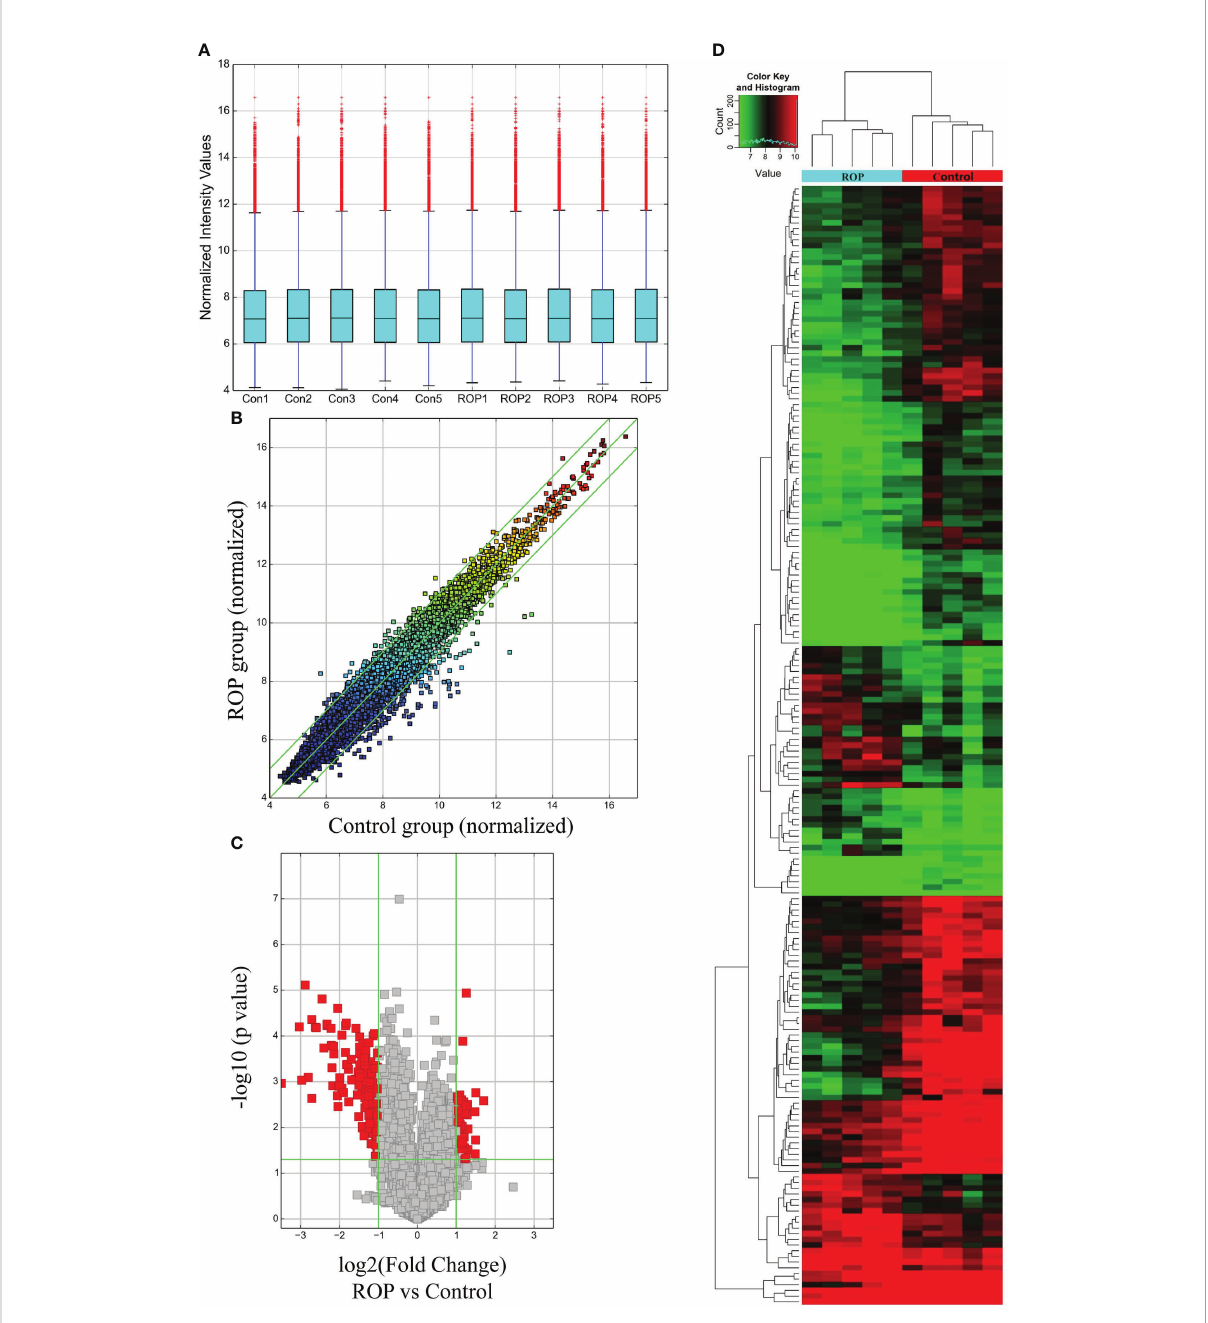
FIGURE 1 Expression pro fi le of circRNAs in retinopathy of prematurity (ROP) patients and controls. (A) A box plot shows the expression pro fi le of circRNAs in each blood sample after normalization. (B) Raw variations of the circRNA expression pro fi le are displayed on a scatter plot. (C) A volcano plot shows signi fi cantly altered circRNAs using a threshold of ≥ 2-fold change and P<0.05. (D) Heatmap derived from hierarchical cluster analysis showing different expressions of circRNAs in each